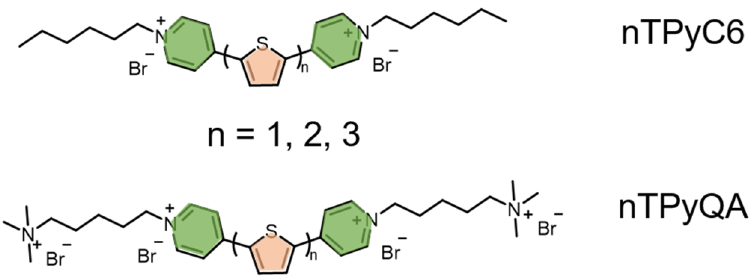
Figure 7. Structures of water-soluble thiophene derivatives for bacteria imaging and